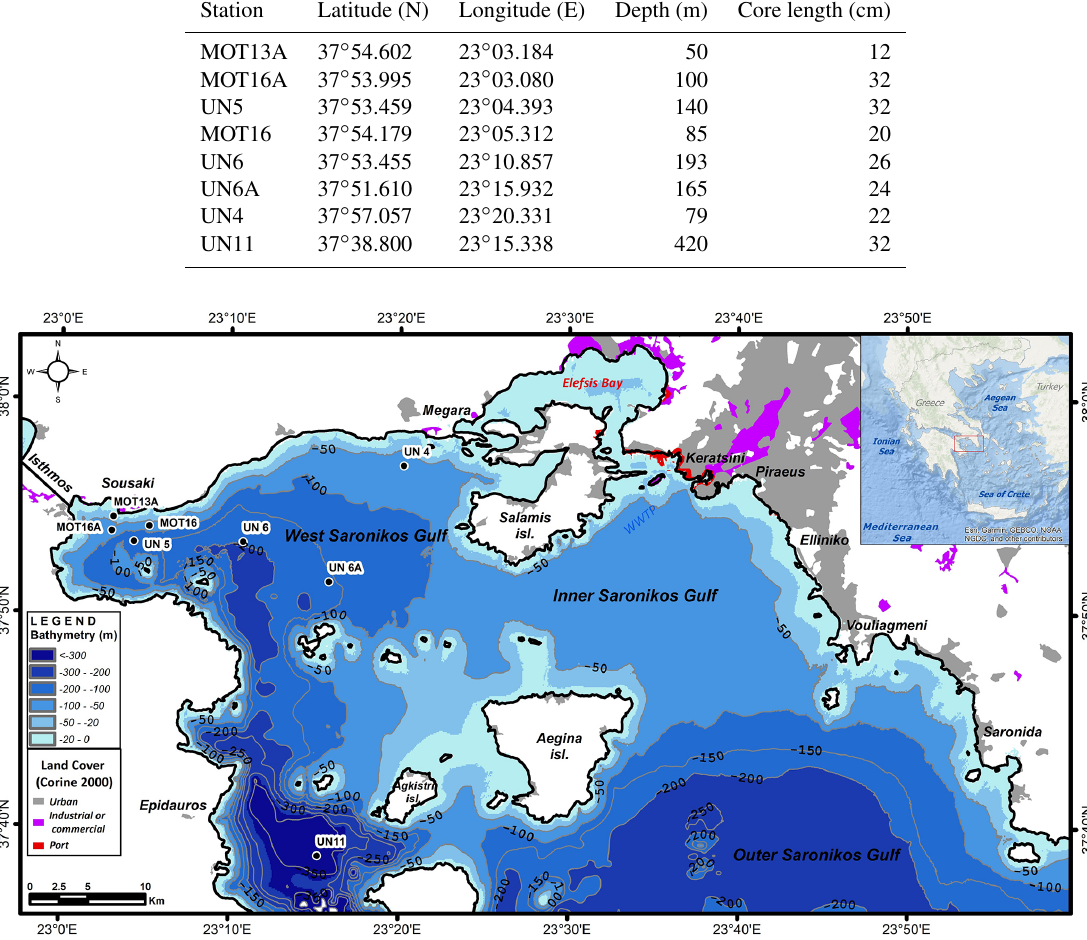
Figure 1. Study area of the western Saronikos Gulf and sampling stations. The map was constructed using Arc Map with bathymetry representation data from the European Marine Observation and Data Network-EMODnet (https://portal.emodnet-bathymetry.eu/, last access: 20 September 2022) and land cover data from Corine